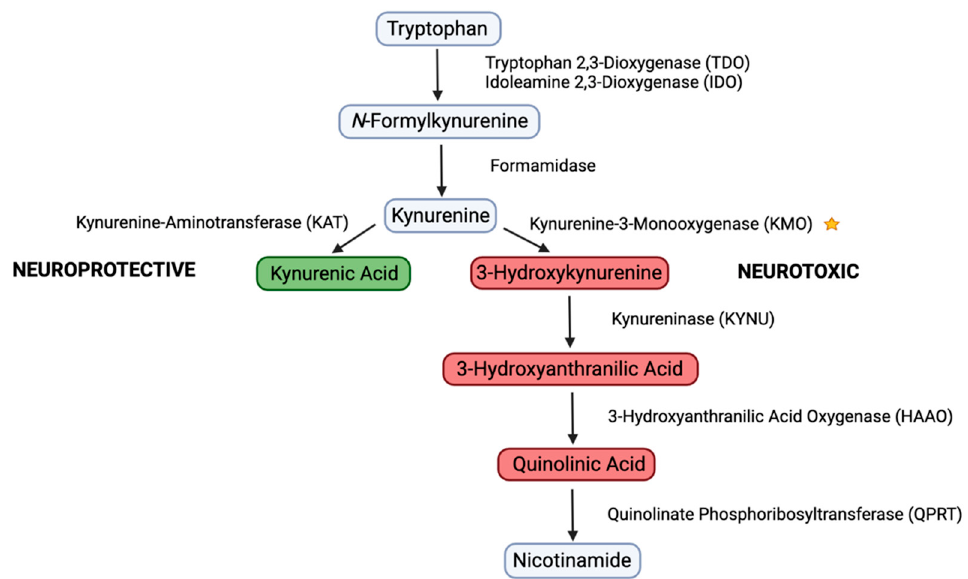
Figure 1. Schematic representation of the kynurenine pathway (KP) consisting of neuroprotective and neurotoxic branches. The downstream neurotoxic products are a target for inhibitors which aim to shift the pathway towards neuroprotective products. The star symbol indicates the enzyme under the current study.